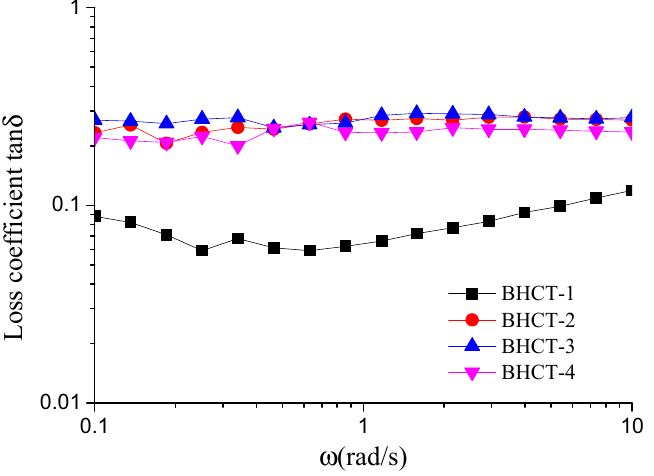
Figure 16. Loss factor of composite gel with different crosslinker contents.